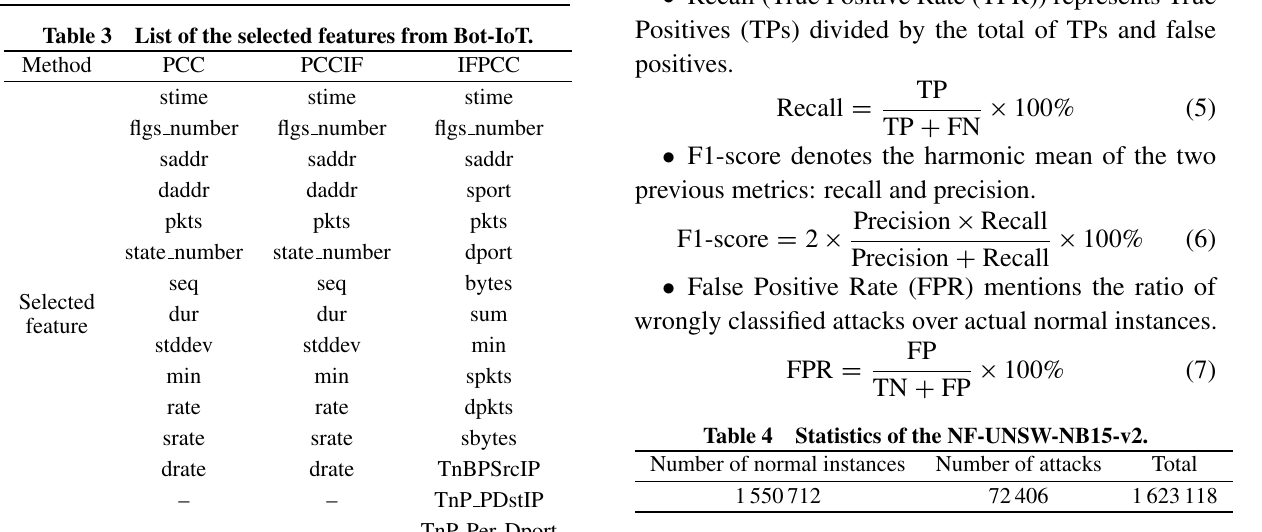
Table 3 List of the selected features from Bot-IoT.